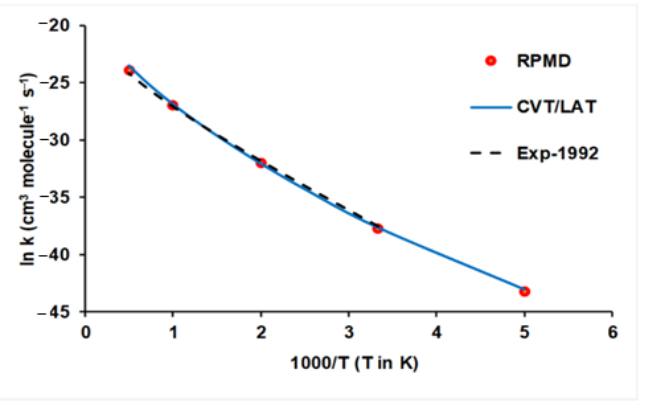
Figure 7. Arrhenius plots of the H + C 2 H 6 thermal rate constants (cm 3 molecule − 1 s − 1 ) computed using the PES-2019 surface in the temperature range 200–2000 K. Blue line: CVT/LAT rate constants; red circles: RPMD rate constants; black dashed line: experiment from Ref. [84].